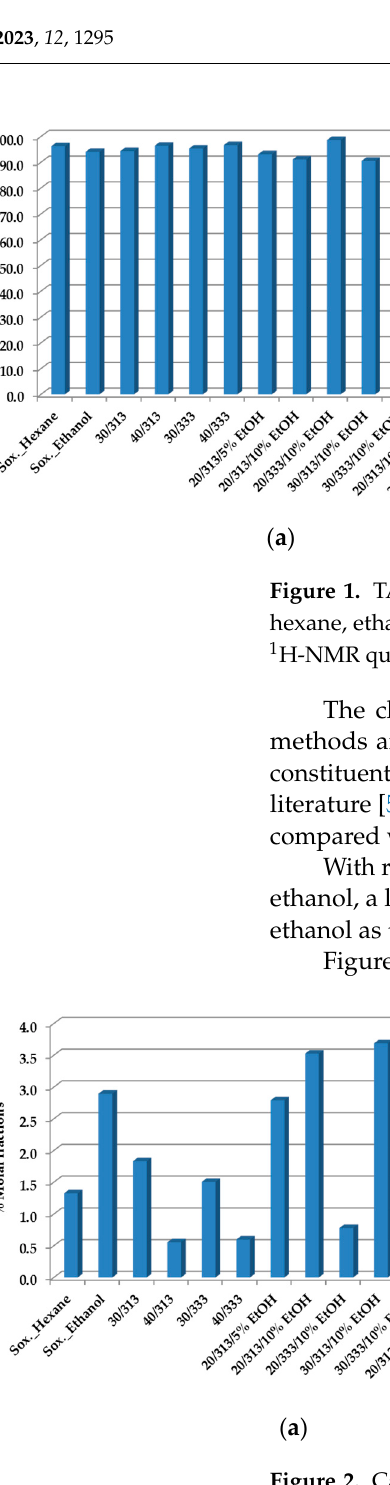
Figure 3. 16-O-Mecafestol ( a ) and kahweol ( b ) composition of spent co ff ee oils obtained by Soxhlet with hexane, ethanol, and scCO 2 extraction at a fl ow rate of F = 1.8 × 10 − 3 kg·min − 1 , as established by 1 H-NMR quantitative analysis [50] . The analysis of the in fl uence of the main extraction conditions, namely, the temperature, pressure, and type of co-solvent applied on the oil yield, and the pro fi le of the principle components outlined the possible paths to follow for the transformation of SCGs to value-added lipid constituents. Thus, the oil yield is increased favorably by raising the pressure and temperature. In addition, the use of a co-solvent allows a 20% increase in the fi nal oil yield. Moreover, the increase in the polarity of scCO 2 with the addition of co-solvents such as ethanol allows a growth in the % of molar fraction of the polar compounds in the oils, as is the case for ca ff eine (Figure 2a). The results clearly demonstrate the potential of SCE as a green advanced technology for extracting oils from SCGs, leading to a reduction in the extraction time and the possibility of changing the composition of the extract through the adjustment of the best scCO 2 conditions and use of the co-solvent.